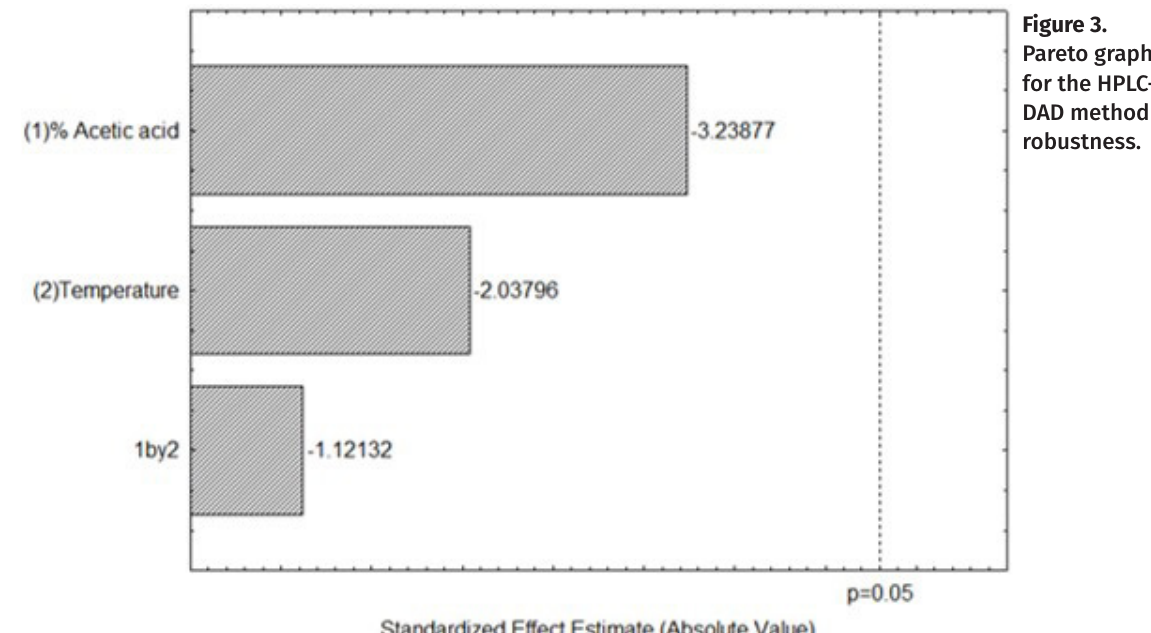
Figure 3. Pareto graph for the HPLC- DAD method